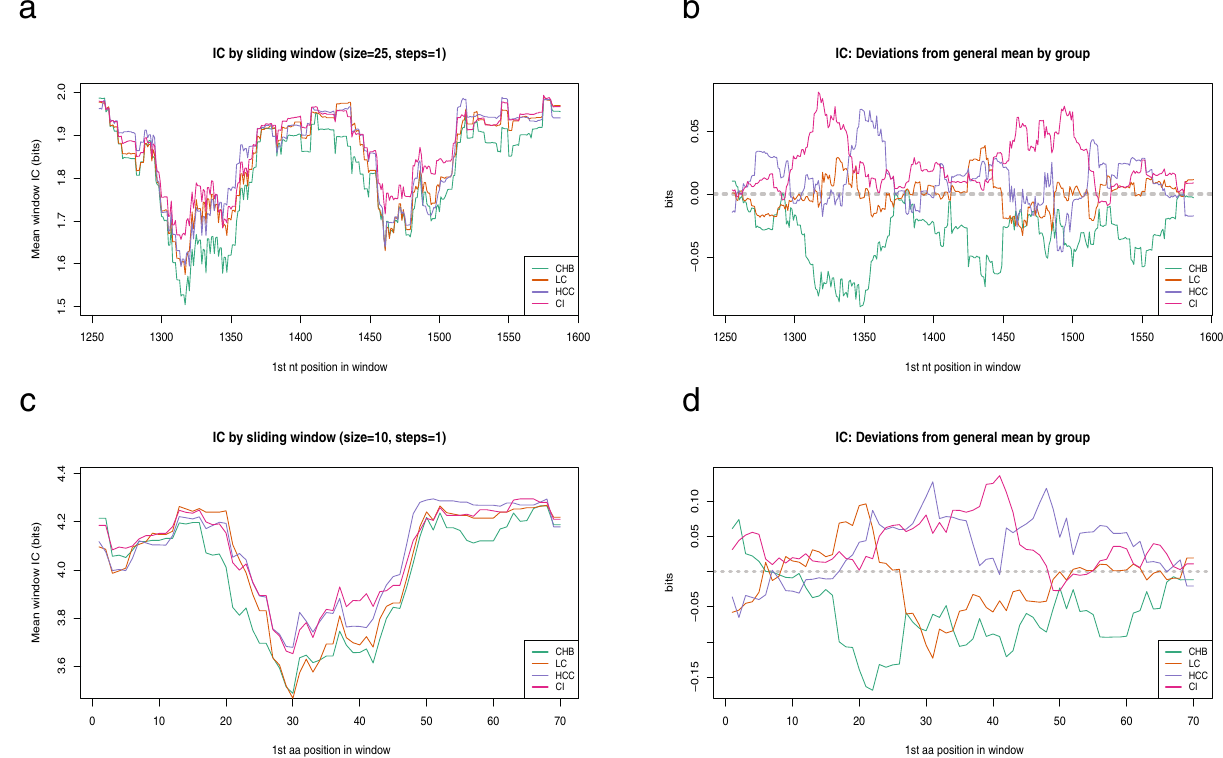
Figure 2. Intergroup variability of the information content. ( a ) The sliding window analysis is the result of the mean information content (bits) of the 25-nt or 10-aa long windows with a displacement between them of 1-nt or 1-aa obtained by multiple alignments of all the QS haplotypes. A. Sliding window analysis of nt sequences in the various clinical groups. Each line displays a specific clinical group (CHB in green, LC in orange, HCC in purple, and CI in pink). ( b ) Representation of the intergroup variability in nt conservation. Each line indicates a group of patients. The information content general mean is highlighted with a grey dotted line (positive deviation indicates greater conservation, whereas negative deviation indicates lesser conservation). ( c ) Sliding window analysis of aa sequences in the various clinical groups. ( d ) Intergroup variability in aa-conservation. Grey dotted line indicates the general mean of information